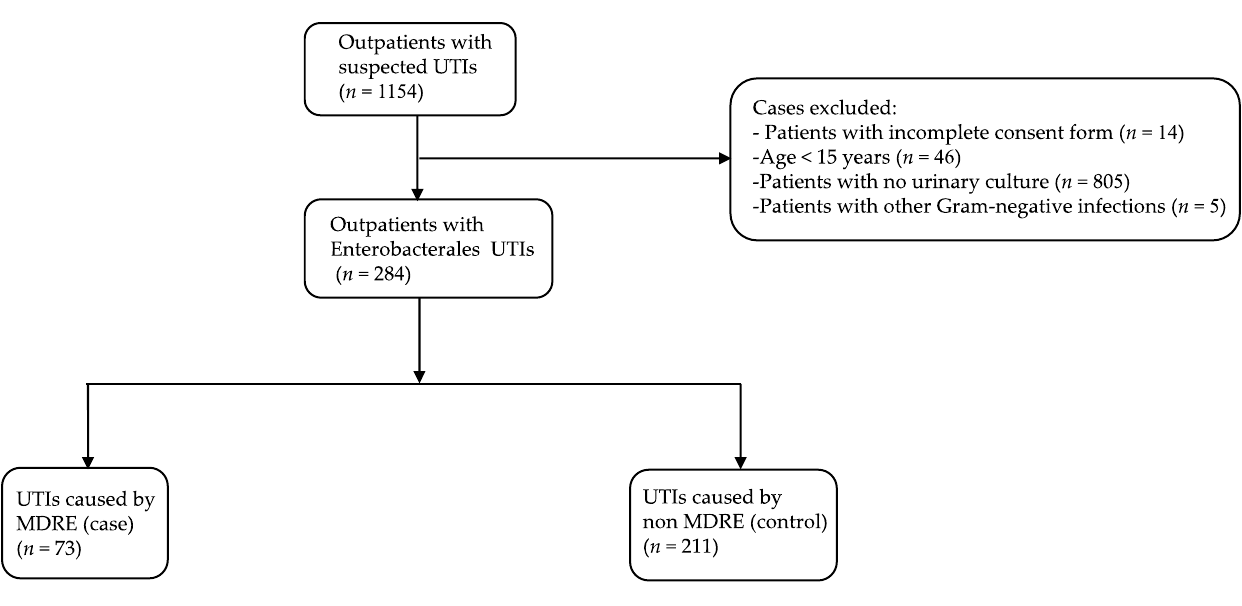
Figure 1. Flowchart of patients included in this study. UTI, urinary tract infection; MDRE, multidrug-resistant Enterobacterales. Table 1. Characteristics of patients with urinary tract infections caused by MDRE and non-MDRE .